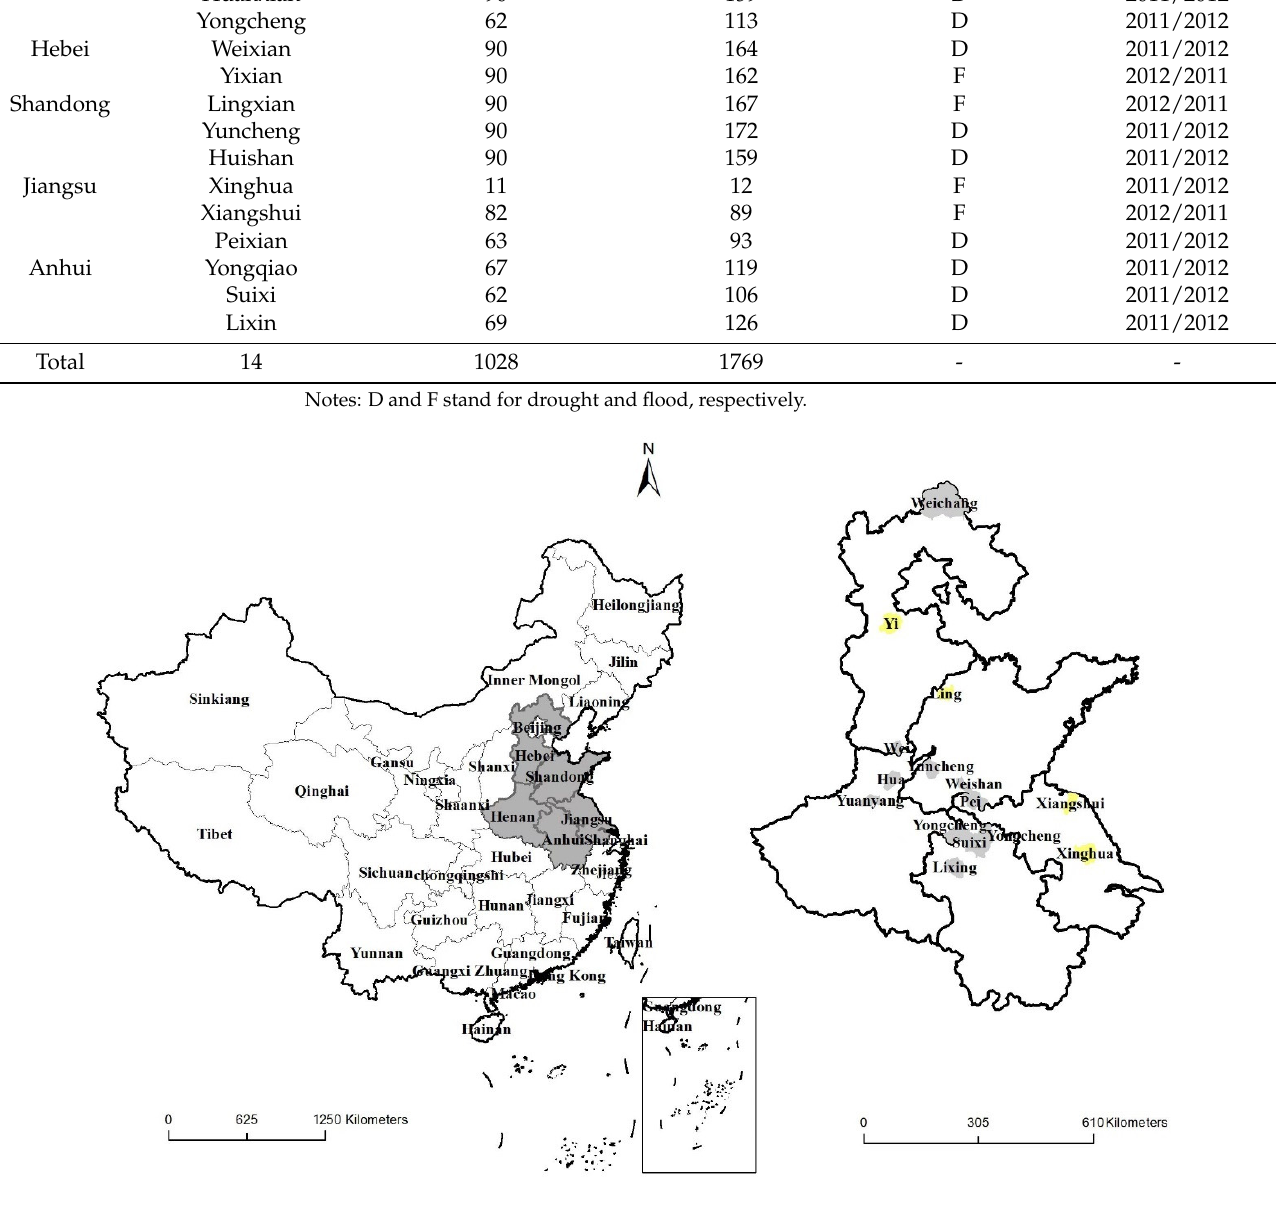
Figure 1. Location of five provinces in the NCP ( left ) and 14 sample counties ( right ).